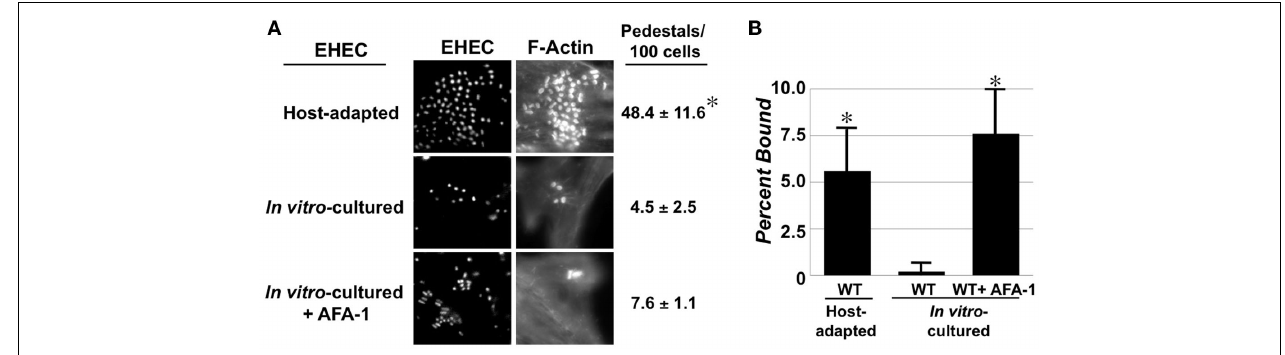
pedestals with Alexa568-phalloidin (”F-actin”).The percentage of actin pedestals ( ± SD) per 100 mammalian cells was determined visually (right). (B) Binding of the same three strains to mammalian cell monolayers was determined by plating for viable counts. Data represent the mean ± SD from three independent experiments. * P ≤